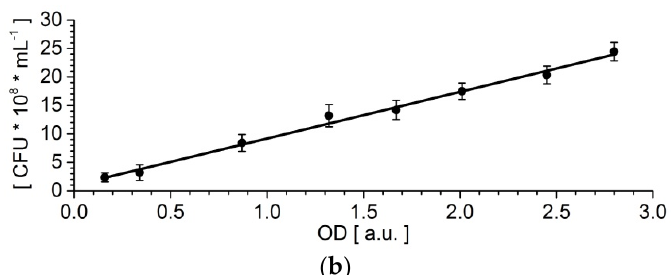
Figure 3. ( a ) The relation between the optical density (OD) of a droplet that was generated in the system and the integrated voltage signal that was recorded by the sensor during the droplet passage. The inset (the dependence of sensor voltage vs. time) shows the area of integration for a passing droplet, where the beginning and the end of the droplet are marked with sharp voltage spikes. ( b ) The correlation between the number of colony-forming units (CFU) per mL and optical density (OD). He colonies were plate-counted after the dilutions of the bacterial culture media. The standard deviations over ten samples were marked on the graphs. The experiments were performed for ∆ p continuous phase = 100 mbar in temperature T = 37 °C.